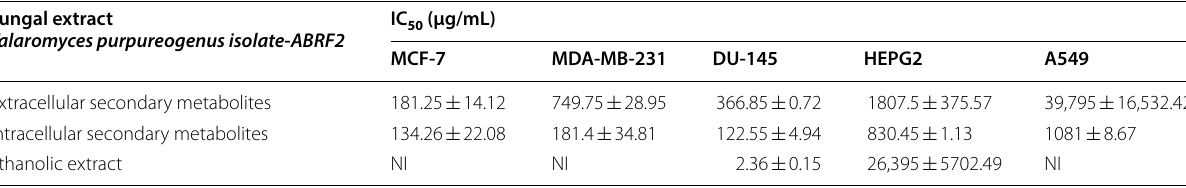
Table 3 IC (µg/mL) value of different extracts of isolate ABRF - 2 ( Talaromyces purpureogenus ) 50 Fungal extract Talaromyces purpureogenus isolate ‑